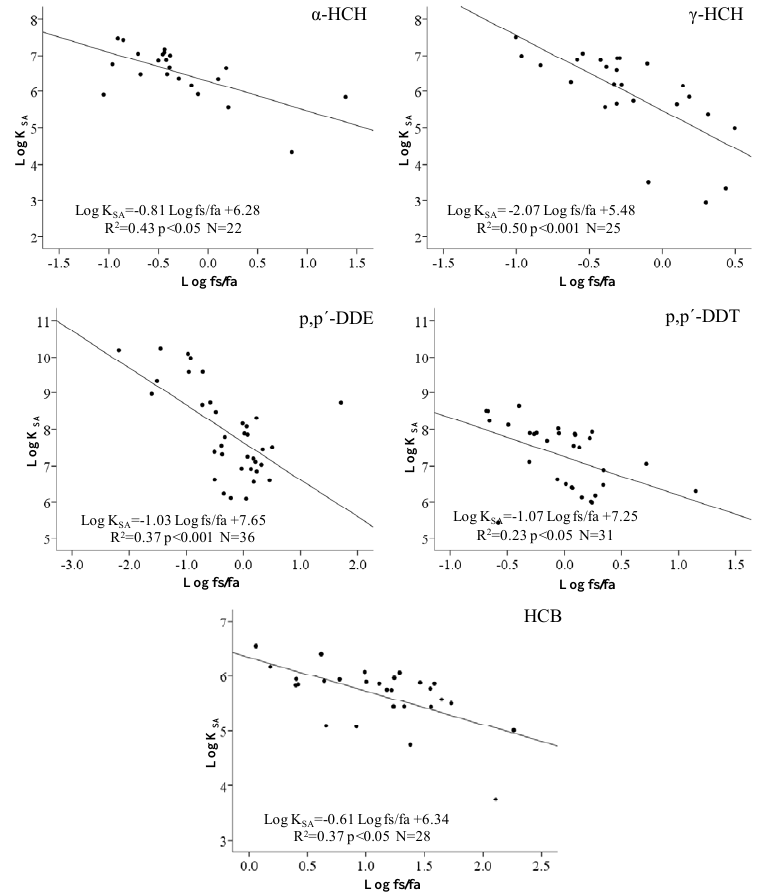
Fig. 7. Soil-air partition coefficient (Log K SA ) regressed versus the soil-air fugacity ratio (Log f s / f a ) for selected